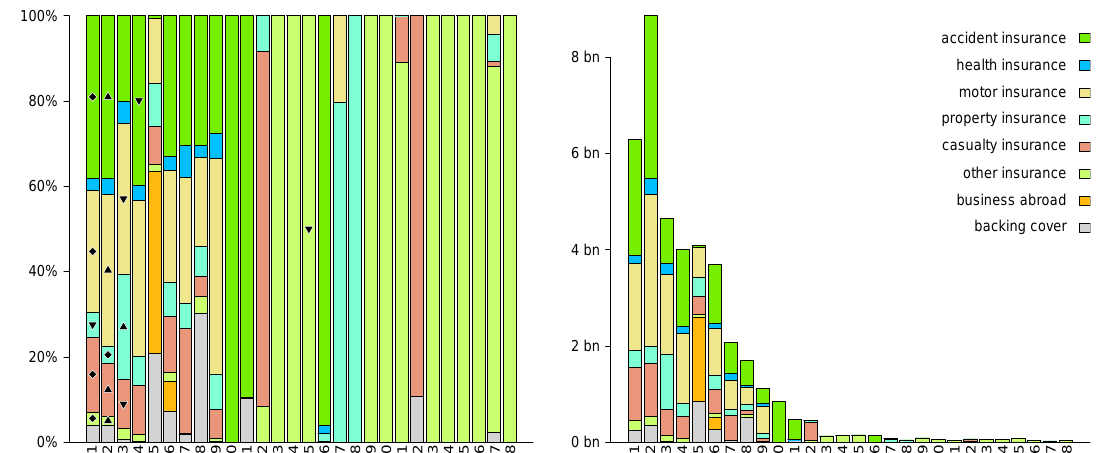
Figure A3. General insurers’ assets ( top ), liabilities ( middle ) and insurance provisions ( bottom ) as used for the case study. Values on (lhs) are relative and in percentage, values on (rhs) are absolute and in billion CHF. For each line of business we indicate by (cid:78) , (cid:7) , (cid:72) the market shares based on earned premiums of the first, second and third largest insurer, respectively.